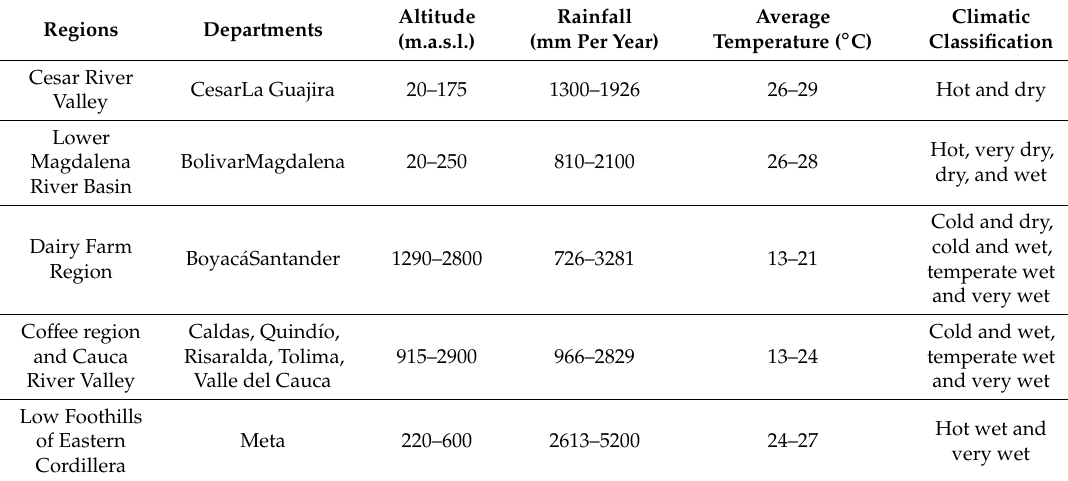
Table 1. Climatic characteristics of the Mainstreaming Biodiversity in Sustainable Cattle Ranching (MBSCR) project eco-regions in